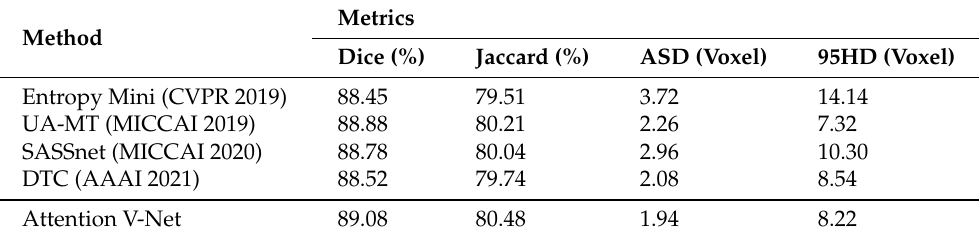
Table 2. Comparison with Other Semi-supervised